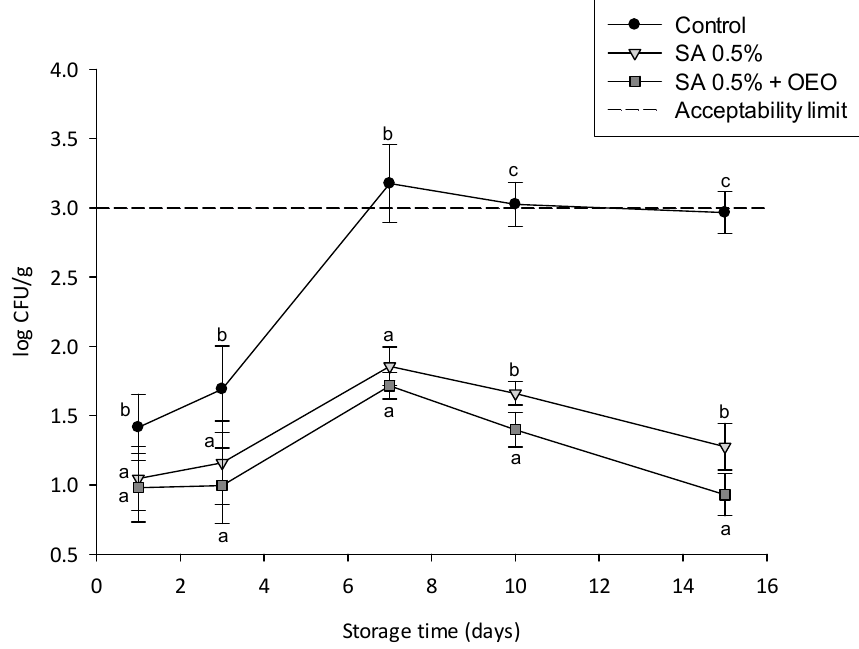
Figure 9. Yeast and mold count over a 14 days storage period at 24 ± 1 °C of uncoated (control, black circles) and tomatoes with an edible coating without (SA 0.5%, light grey triangles) and with OEO nanoemulsion (SA 0.5% + OEO, grey squares). Different letters denote significant differences ( p < 0.05) among the different samples for each day of storage.